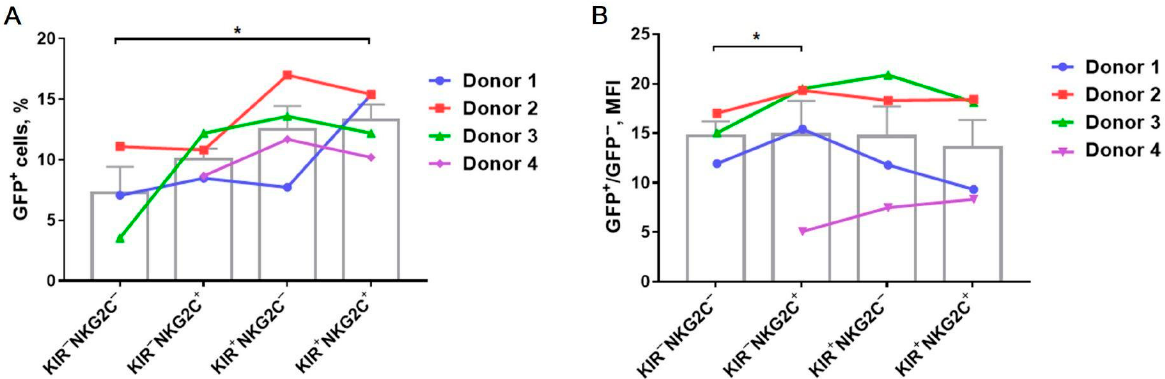
Figure 3. A comparison of the transduction efficiency of the CD57 − KIR2DL2/DL3 +/ − NKG2C +/ − NK cell subsets stimulated with K562-mbIL21 and IL2 by retroviral particles with iCasp9 and GFP genes on the 5th day after infection. ( A ) The proportion of GFP + NK cells in the indicated subsets. ( B ) The GFP mean fluorescence level (MFI) in the indicated NK cell subsets divided by the MFI of the respective GFP − NK cells, n = 4. ( A , B ) Statistical analysis was performed using a paired t -test (* p < 0.05). Columns represent means ± SE. Data from individual donors are linked by lines.